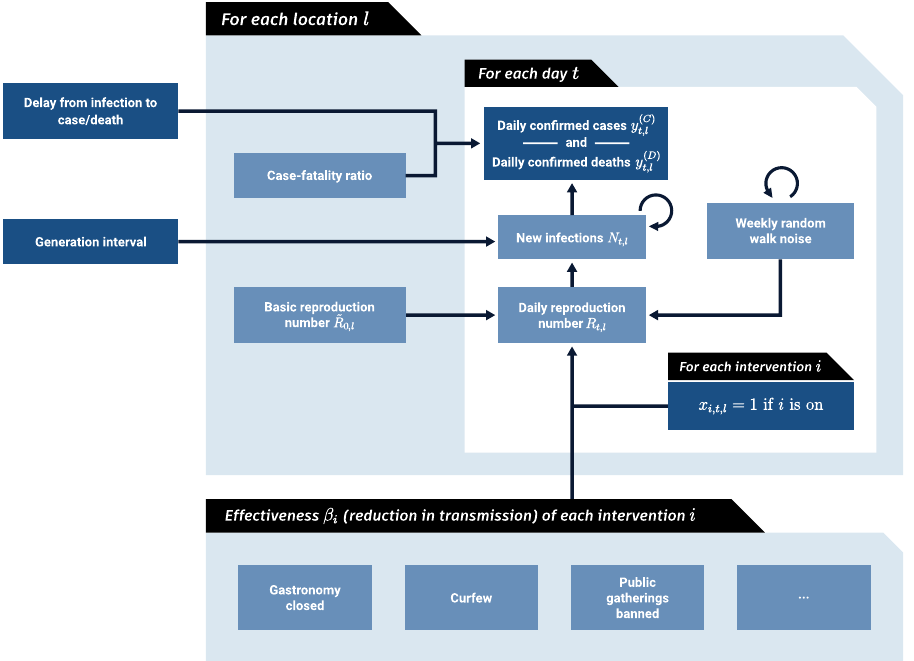
Fig. 4 Model Overview. Dark blue nodes are observed. We describe the diagram from bottom to top. The mean effect parameter of NPI i is β i . On each day e R t , a location ’ s reproduction number R fi c latent weekly t ; l depends on the basic reproduction number 0 ; l , the NPIs active in that location and a location-speci random walk. The active NPIs are encoded by x i ; t ; l , which is 1 if NPI i is active in location l at time t , and 0 otherwise. A random walk fl exibly accounts for trends in transmission due to unobserved factors. R t ; l is used to compute daily infections N t ; l given the generation interval distribution and the infections on previous days. Finally, the expected number of daily con fi rmed cases y C ð Þ t ; l and deaths y D ð Þ t ; l are computed using discrete convolutions of N t ; l with the relevant delay